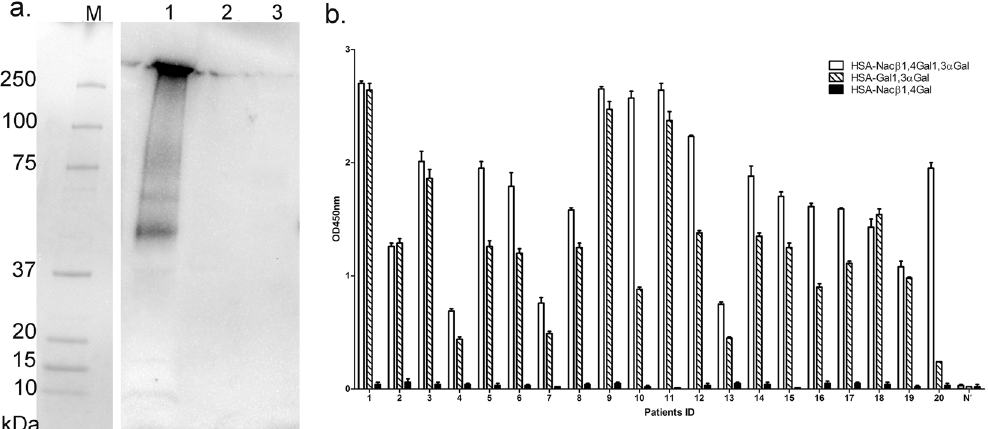
Figure 6. Mapping and influence of other glycans on IgE-reactive peptides. ( a ) Detection of Neu5Gc on bovine thyroglobulin and the corresponding digestion products using an anti-Neu5Gc antibody. Lane 1–Bovine thyroglobulin; Lane 2–Bovine thyroglobulin peptides obtained after 60 minutes of gastric digestion; Lane 3–Porcine pepsin only as control after 60 minutes of digestion; M–Molecular weight markers. ( b ) Patient IgE binding to HSA-NAc- β -1,4-galactose- α -1,3-galactose, HSA-galactose- α -1,3-galactose and HSA-NAc- β -1,4- galactose as measured by